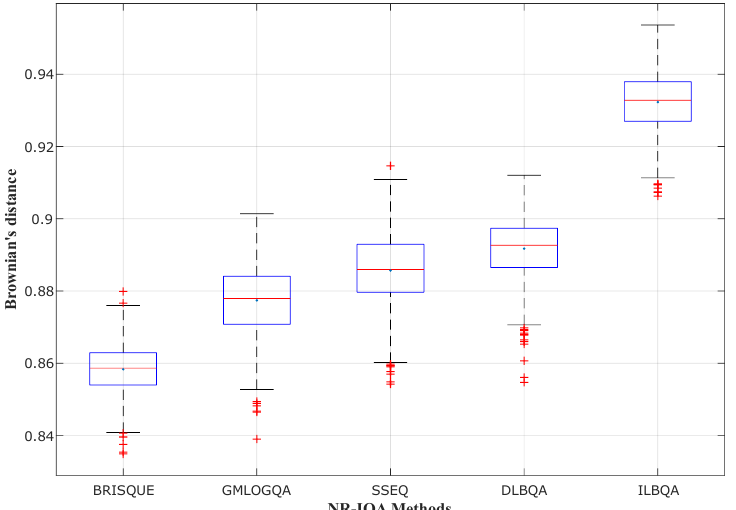
Figure 4. Performance comparison for different NR-IQA methods trained on